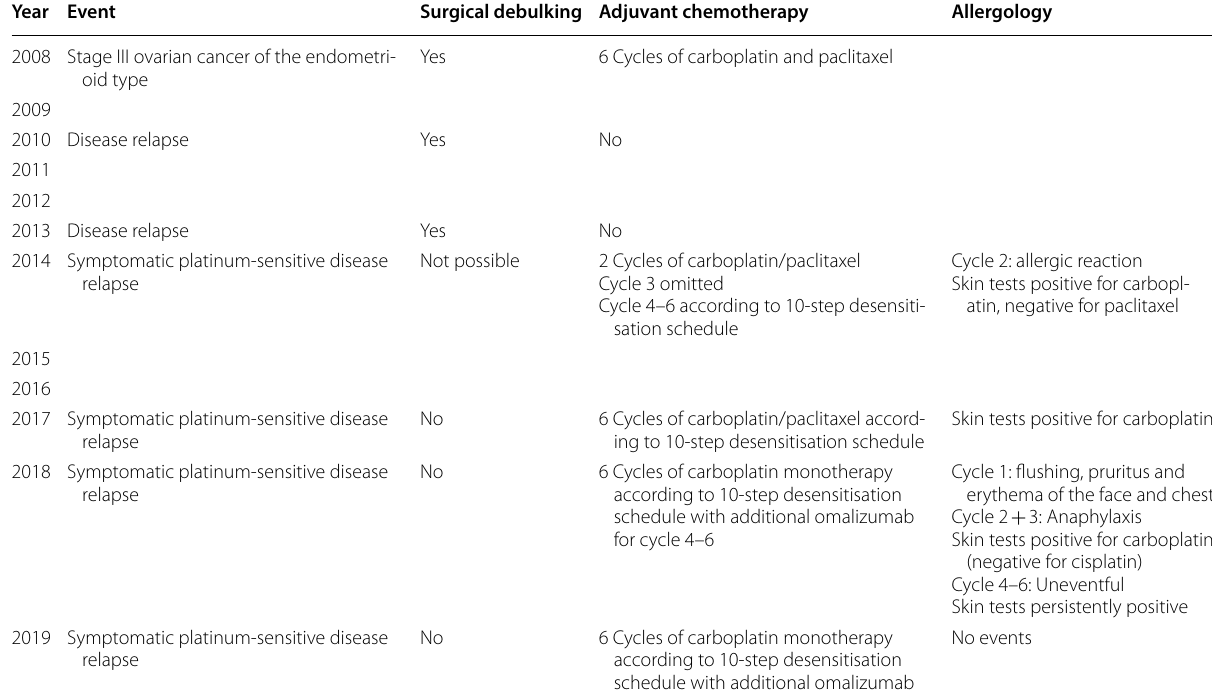
Table 1 Summary of clinical events and treatment over time